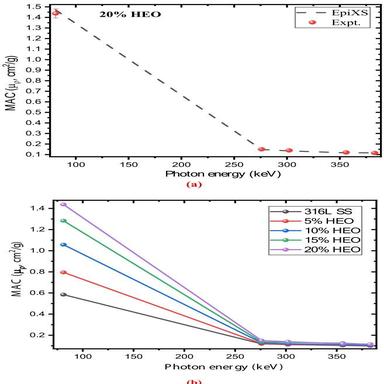
(a and b): (a) Comparison of MAC values obtained from experimental and theoretical calculations (b) Variation of mass attenuation coefficient (MAC) against photon energy for the fabricated HEO samples.